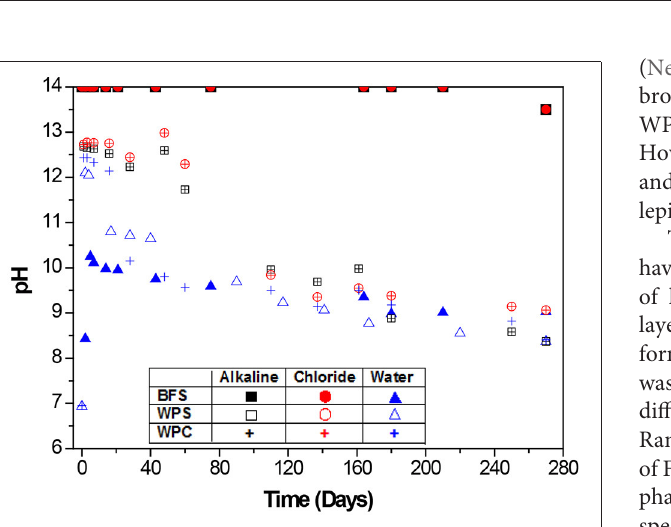
FIGURE 5 | Measured pH values of the three environments: alkaline and alkaline chloride-rich solutions, and water, in which BFS, WPS, and WPC mortars were